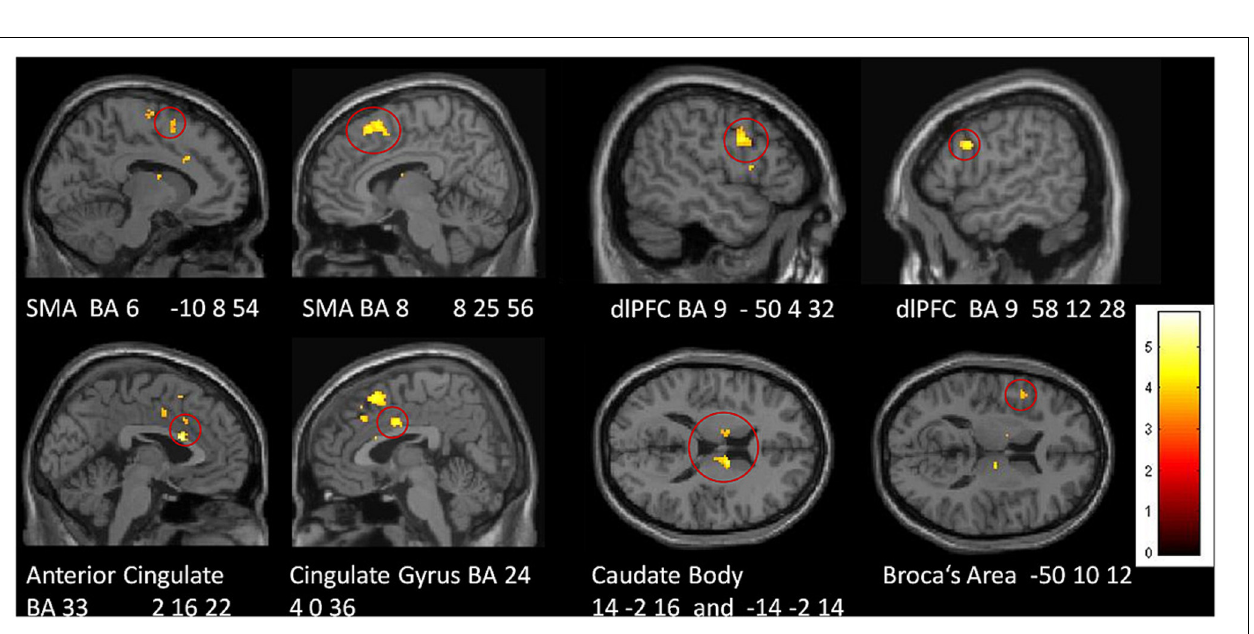
FIGURE 5 | Areas of reduced activation in the tiapride group, compared to the placebo group, in reproduction of the learned motor sequence (two-sample t -test, contrast placebo > tiapride reproduction > improvisation, thresholded at p < 0 . 001 uncorrected, minimum cluster size = 10